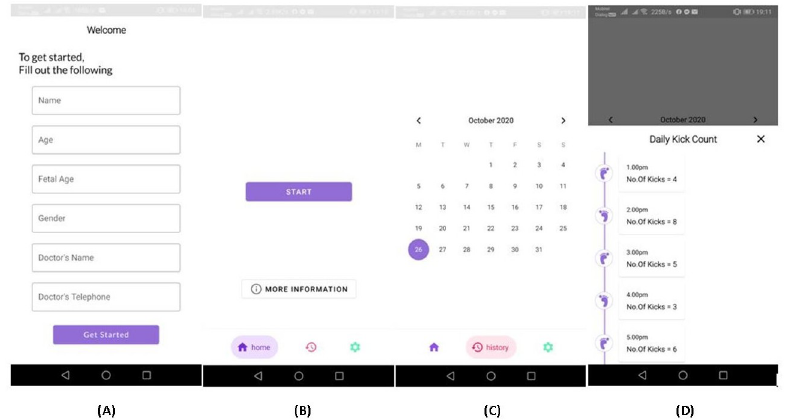
Fig 9. Designed mobile application interface. In this figure few screenshots captured from the designed mobile application can be observed. (A) This shows the interface when the app is launched initially. There details of the pregnant mother as well as the obstetrician are collected. (B) This shows the interface where a mother can upload the recorded data from the micro SD card. When the ‘Start’ button is pressed the data will be captured by the software and sent to the cloud to be analyzed. Subsequently the number of fetal movements occurred during the session will be displayed. (C),(D) As shown, the history of the recorded data can be also